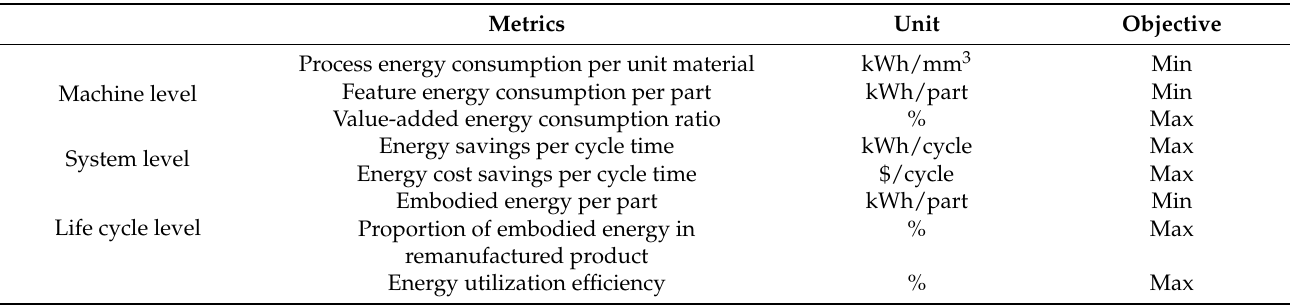
Table 2. Energy sustainability metrics at three modeling